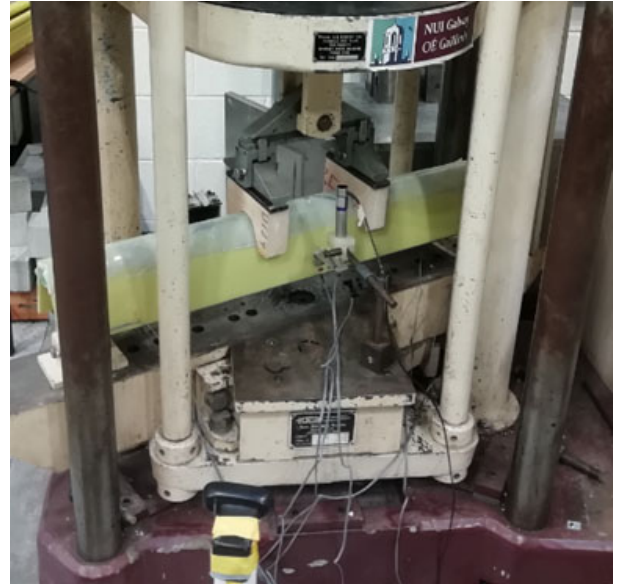
Figure 5. The leading edge demonstrator installed for a four-point bending test in the Denison 500 test machine at NUI